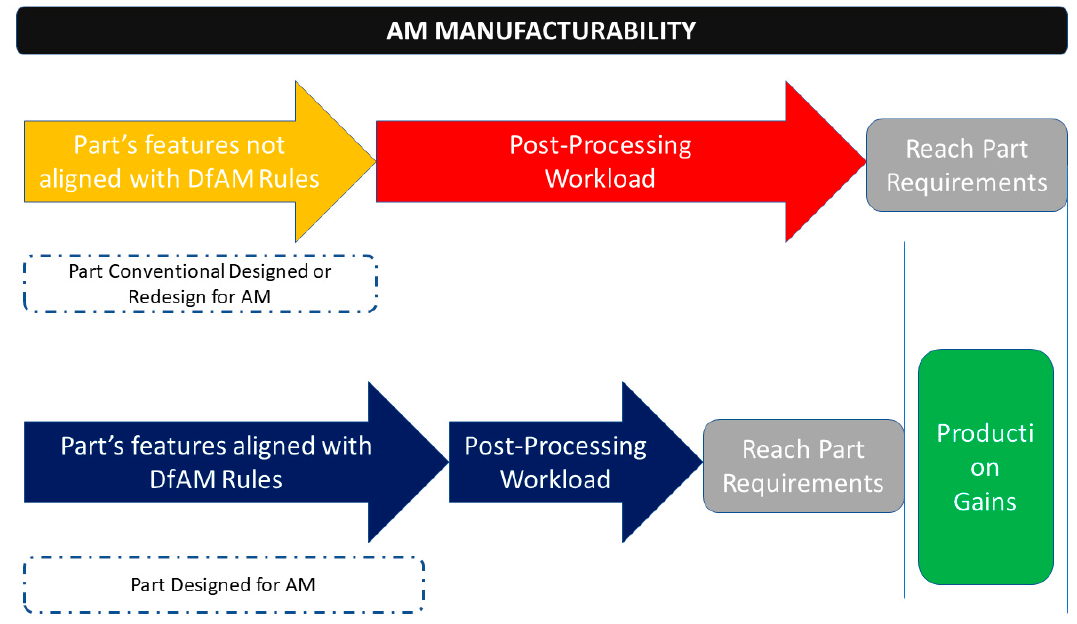
Figure 3. The effect of DfAM rules on production and post-processing workload.